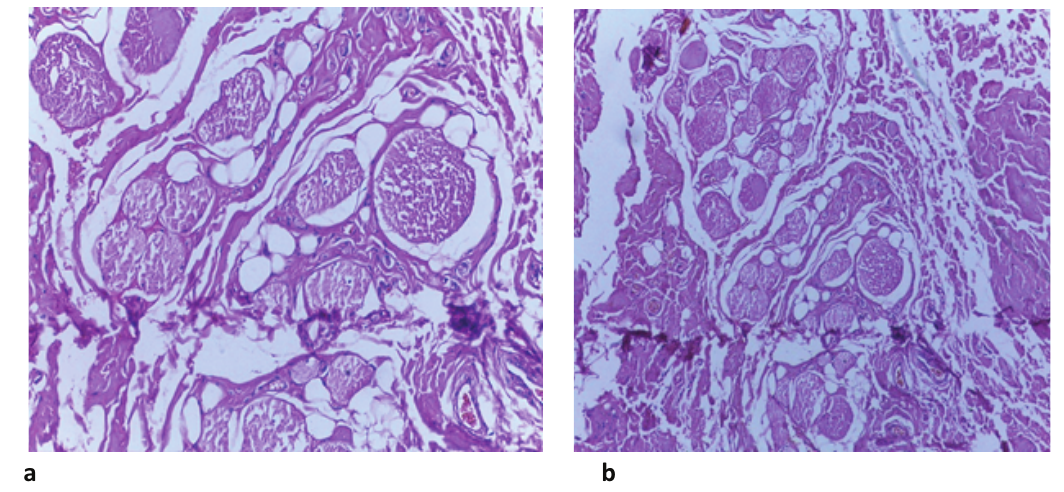
Figure 3: E&M muscle biopsy from affected muscles showed variation in fiber size with groups of angular fibers, preserved fibers, and hypertrophic fibers with marked fibrosis and adipose tissue replacement with no apparent inflammation and necrosis which is consistent with pathological features muscular